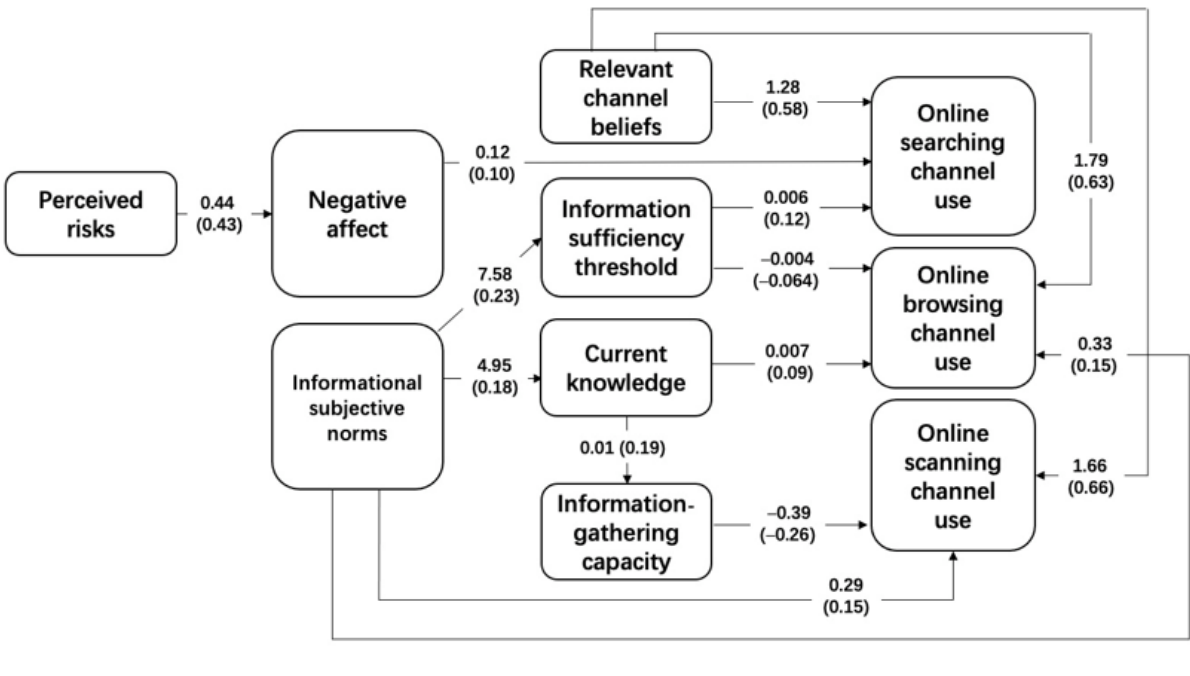
Figure 2. Revised model. The numbers in parentheses are standardized coefficients and the numbers preceding the parentheses are unstandardized